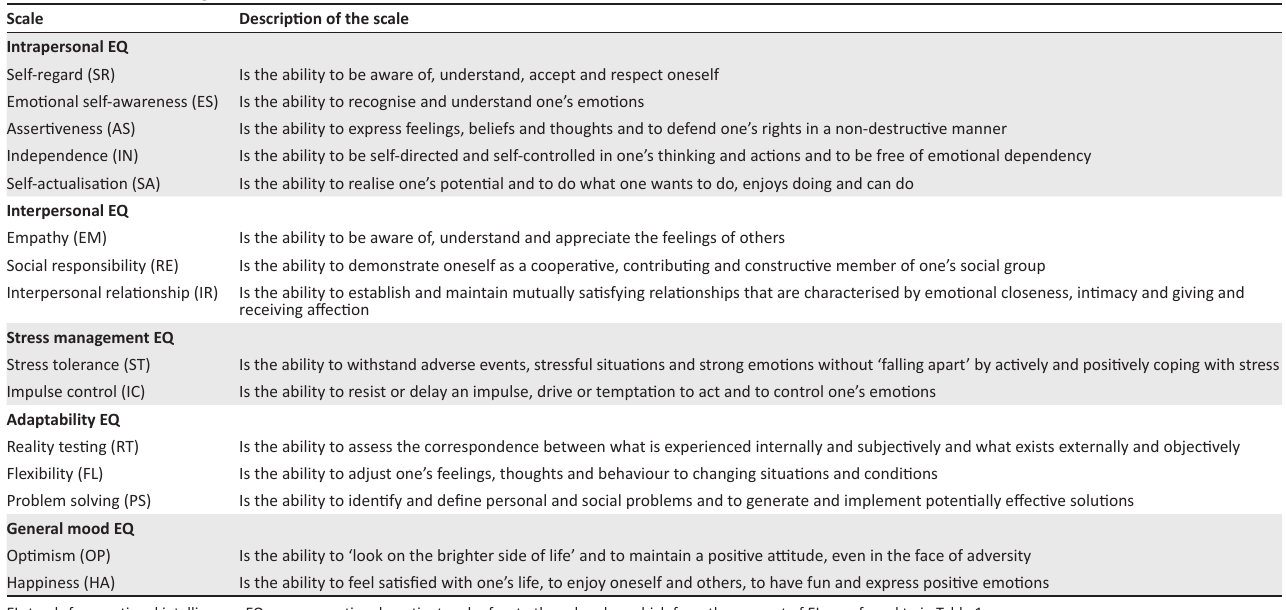
TABLE 1: Emotional intelligence